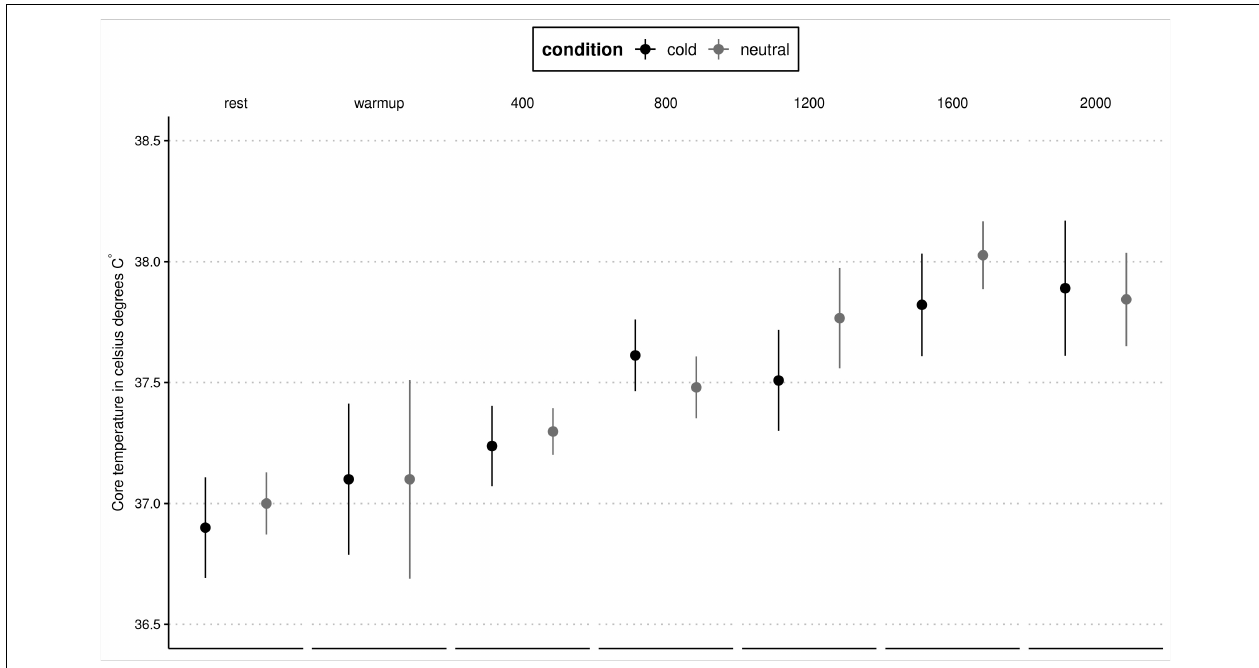
FIGURE 3 | Core temperature during training with the Cold-water cooling and Neutral water-cooling. Mean values and SD are